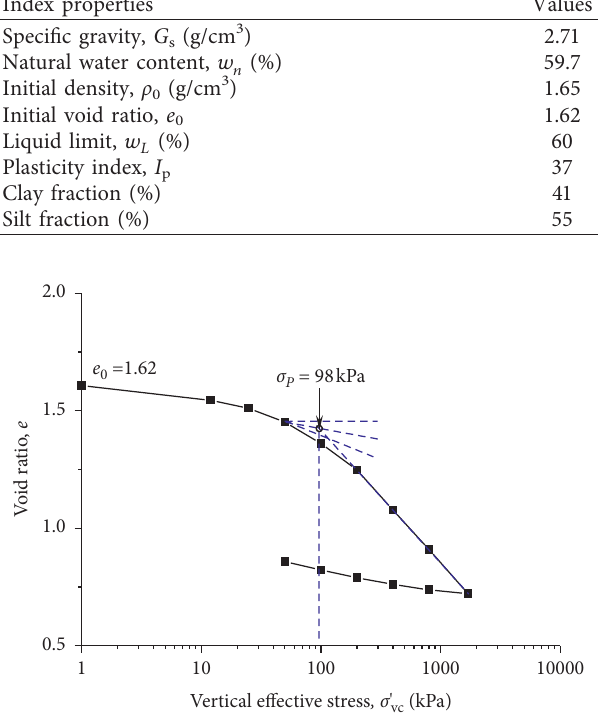
Figure 1: Compression curve of samples from odometer